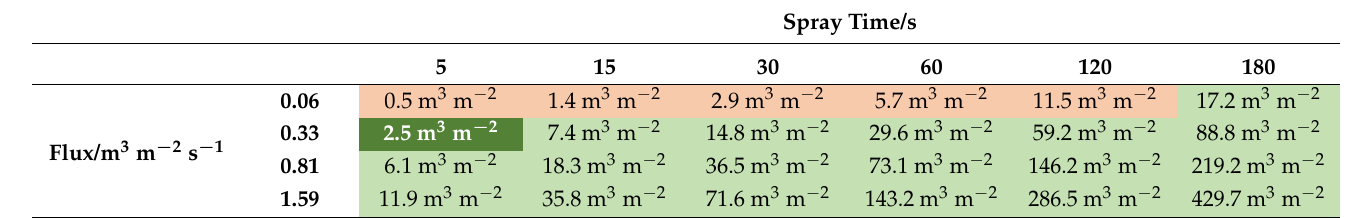
Table 5. Water demand per square meter for all front-wash cleaning parameter combinations. The color background is based on the cleaning performance. A cleaning performance above the threshold of a one-hundred-fold increase in flow in relation to the blinded cloth is marked in green and insufficient regeneration in red. Highlighted in dark green is the successful combination with the lowest water demand.